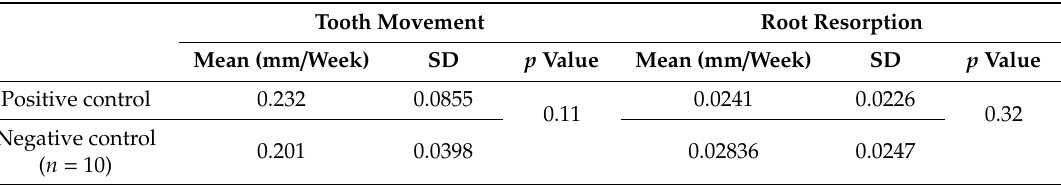
Table 1. Comparison of the weekly rate of tooth movement and root resorption between the positive and negative control